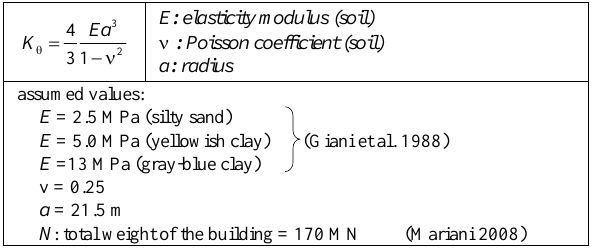
Table 3. Rotational stiffness K θ of a circular rigid foundation resting on a semi-infinite homogeneous elastic soil deposit (Bowles, 2001) In this simple assumption and by imposing that rotation  towards the north is only due to gravity load (= 170MN) foundation level should have an eccentricity of about 1.4